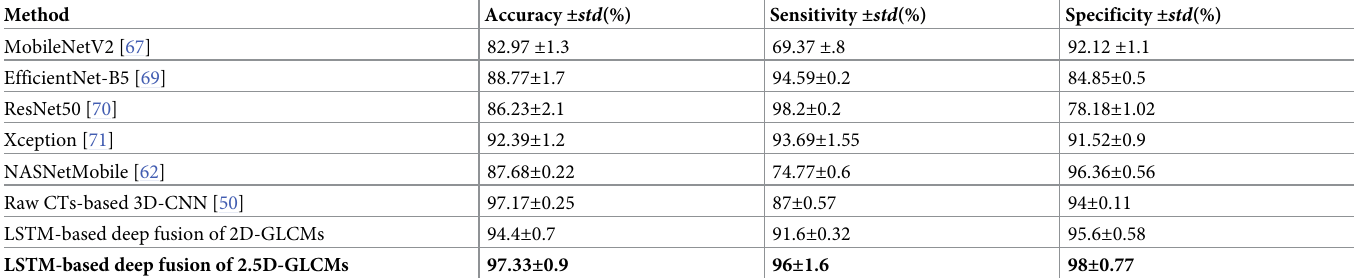
Table 3. A comparison between the proposed 2D and 2.5D GLCM fusion methods and other deep CNN-based methods regarding the accuracy, sensitivity, and spec- ificity metrics.